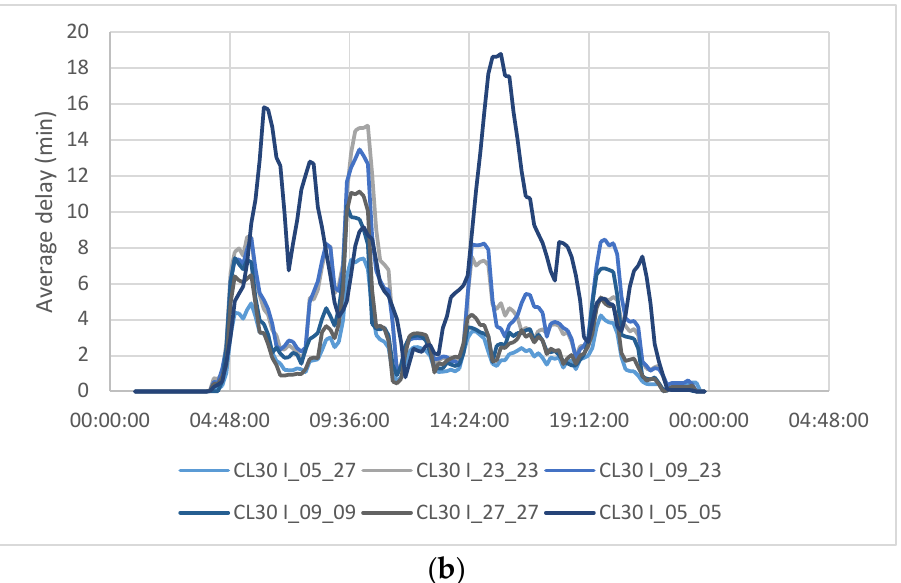
Figure 7. Comparison of the average delay for all the examined scenarios ( a ) CL00; ( b ) CL30 .